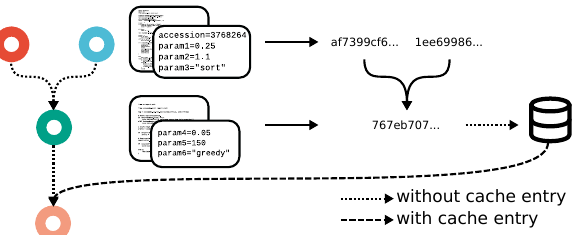
Figure 5. Blockchain-hashing based between workflow caching scheme of Snakemake. If a job is eligible for